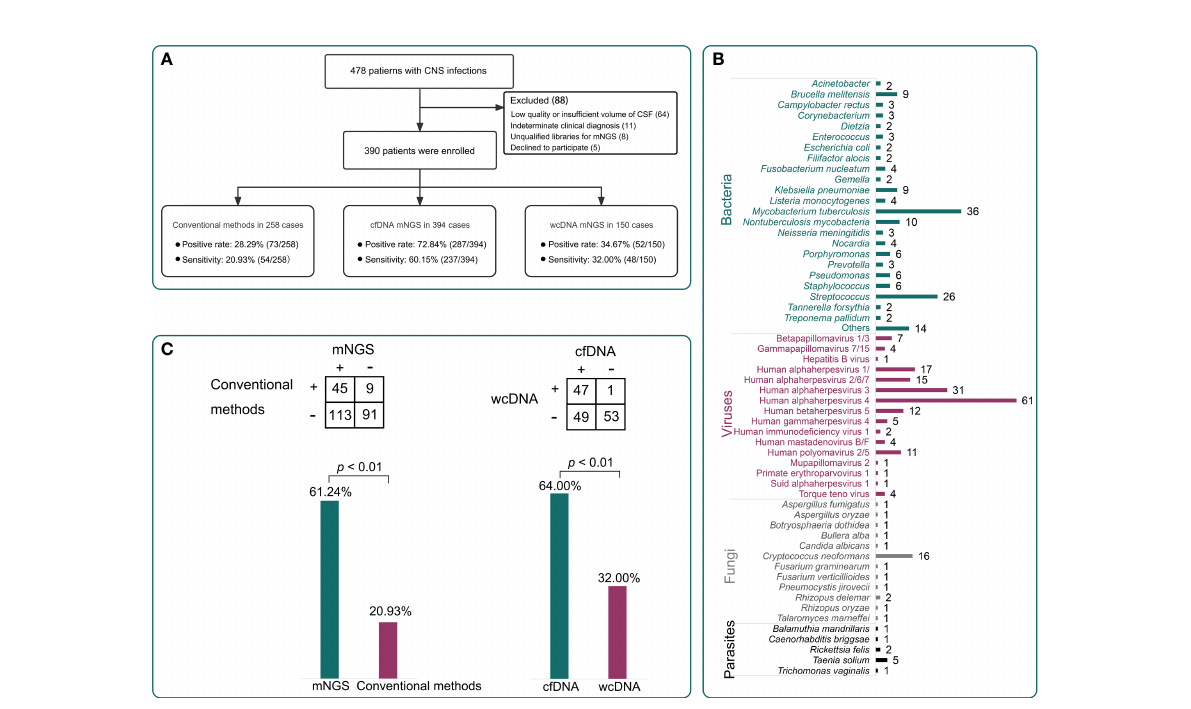
FIGURE 1 Patient enrollment and the performance of different methods. (A) , A total of 390 patients were enrolled in this study. The positive rates of conventional methods, metagenomics next-generation sequencing (mNGS) using cell-free DNA (cfDNA), and mNGS using whole-cell DNA (wcDNA) were 28.3%, 72.8%, and 34.7%, respectively. The sensitivities were 20.9%, 60.2%, and 32.0%, respectively. (B) , The pathogen pro fi les by the mNGS of cfDNA. (C) , Comparisons among different methods. The mNGS of cfDNA showed signi fi cantly higher sensitivity than the mNGS of wcDNA and conventional methods ( P <